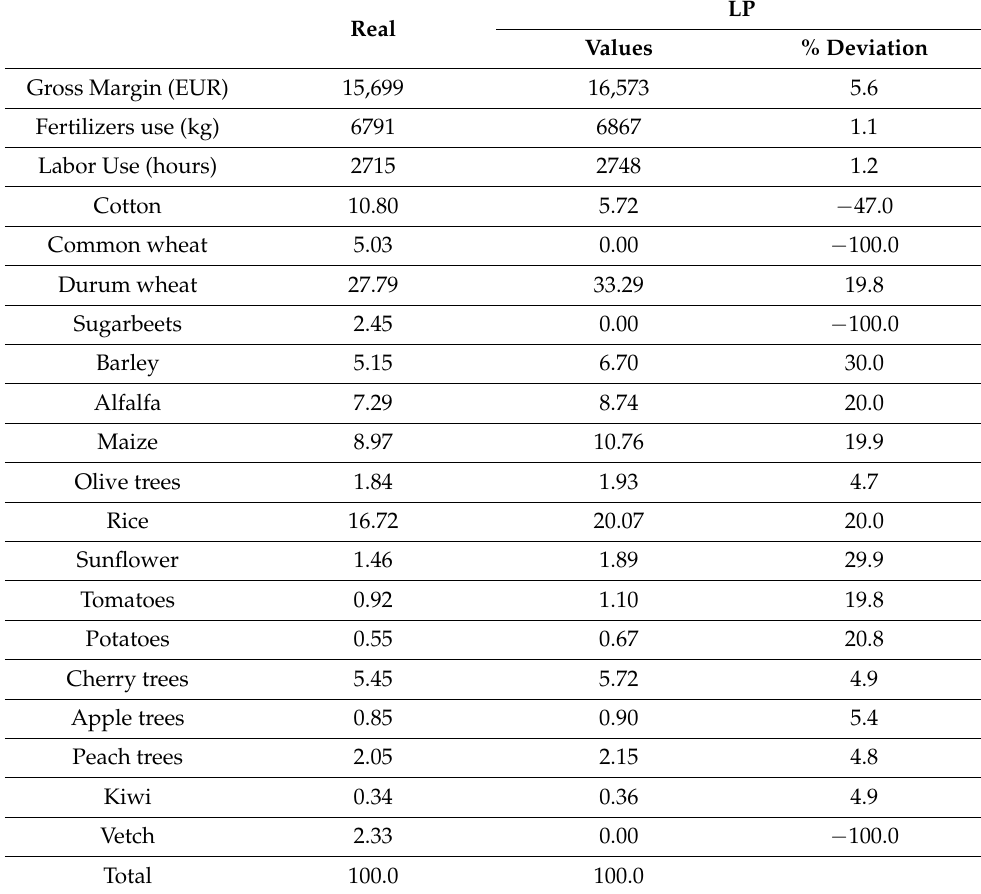
Table 2. Comparison of the Real crop plan vs. LP crop plan. Source: Our